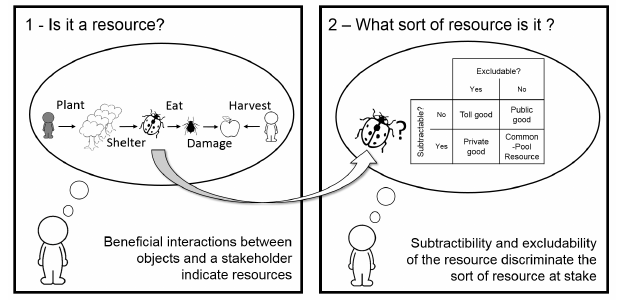
Fig. 1. Two-step theoretical approach to explore the social construction of a resource. (1) In this example, the hedgerow and natural enemies are resources because they are perceived as bringing a pest-regulating benefit. (2) From interviewee perception and speech, we analyze excludability and subtractibility of resources because these factors orient toward management